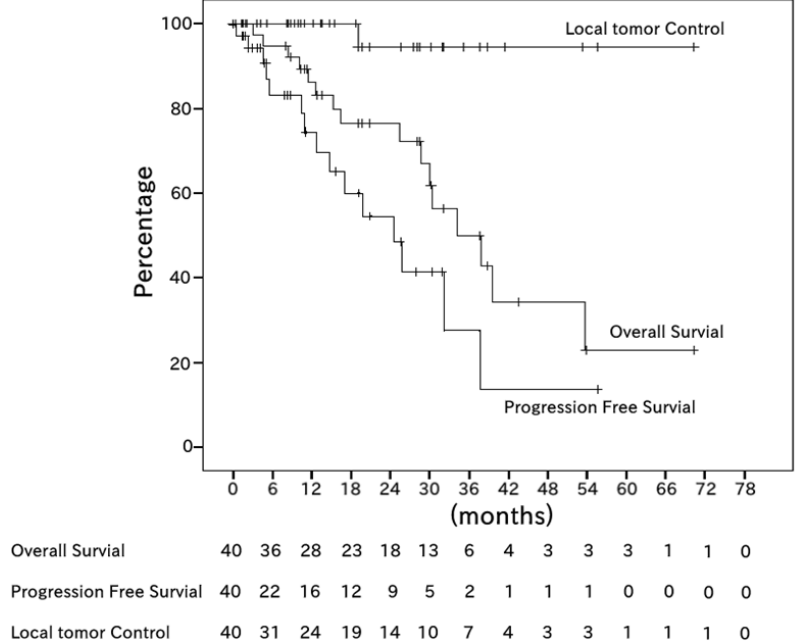
Figure 1. Kaplan – Meier estimates of overall survival (OS), progression-free survival (PFS), and local tumor control (LTC) among all 40 patients. The median OS period was 20.8 months (range, 1.3 – 72.3 months). The median PFS period was 9.8 months (range, 0.0 – 57.2 months). The 2-year OS, PFS, and LTC rates were 76%, 60%, and 94%, respectively.